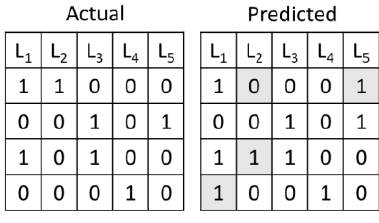
Figure 3. Example of Hamming loss.